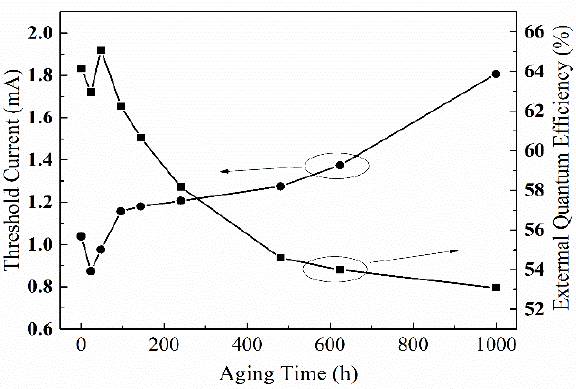
Figure 3. Relationship between threshold current and external quantum efficiency versus aging time.